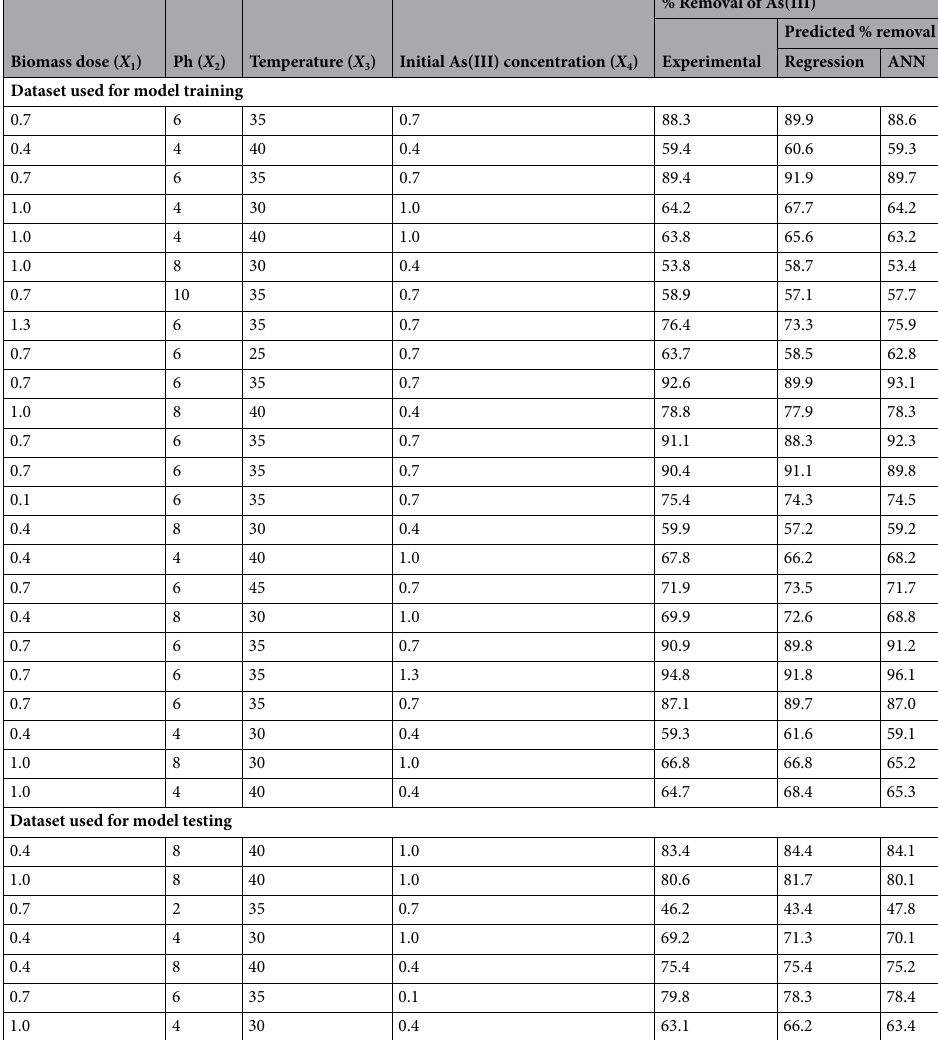
Table 2. Full factorial CCD of 31 trials with experimental and model based predicted